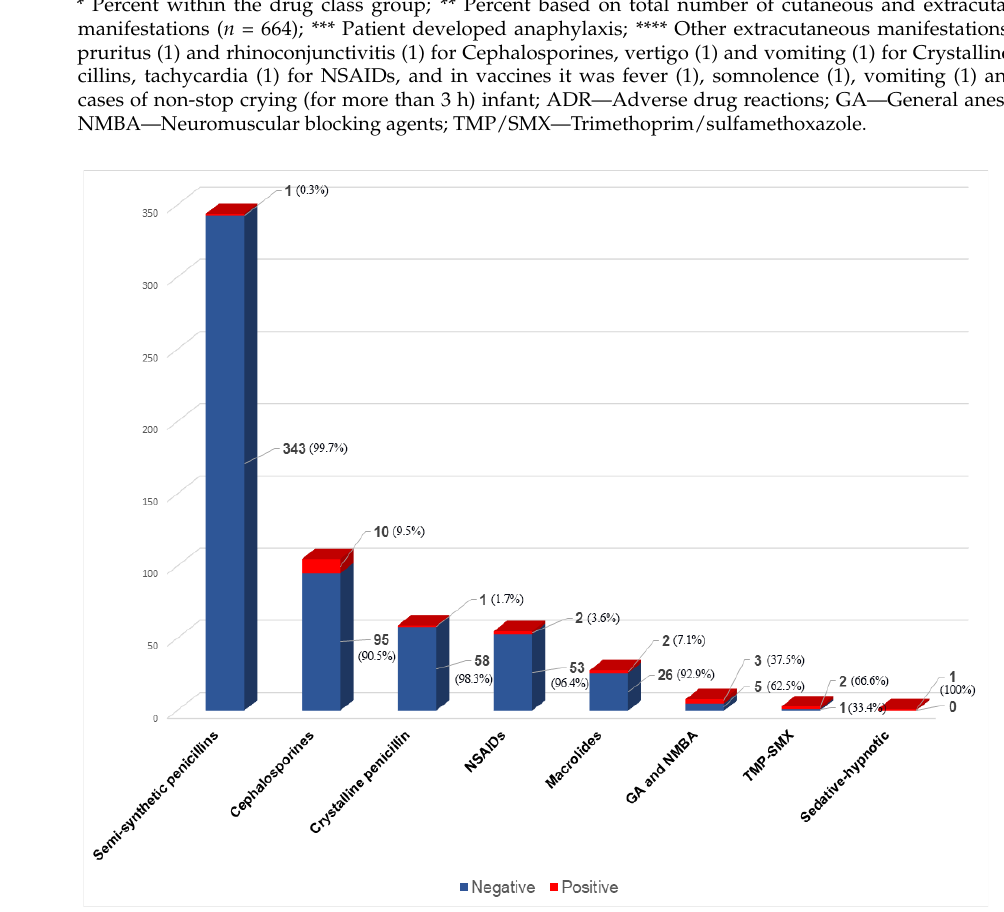
Figure 2. Ratio between proven and excluded DHRs. DHRs — Drug hypersensitivity reactions; SS penicillins — semi-synthetic penicillins; NSAIDs — non-steroidal anti-inflammatory drugs; GA — general anesthetics; NMBA — neuromuscular blocking agents; TMP-SMX — trimethoprim-sulfamethoxazole